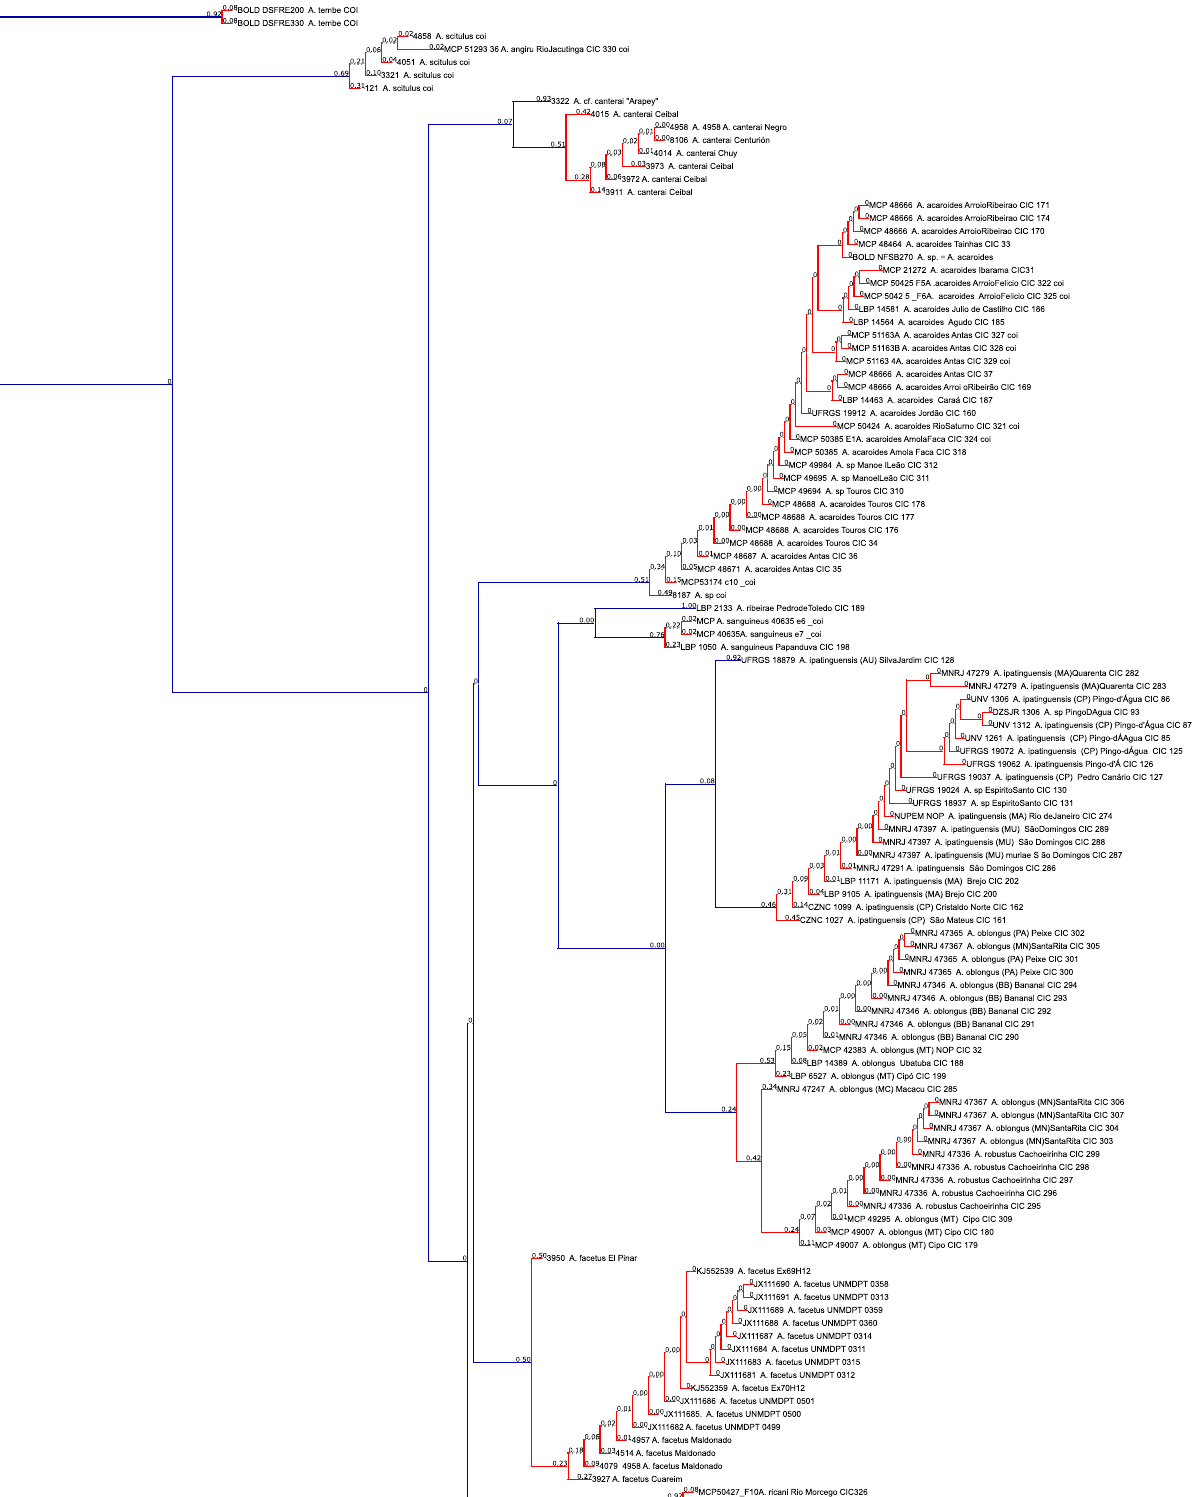
PLOS ONE | https://doi.org/10.1371/journal.pone.0261027 December9,